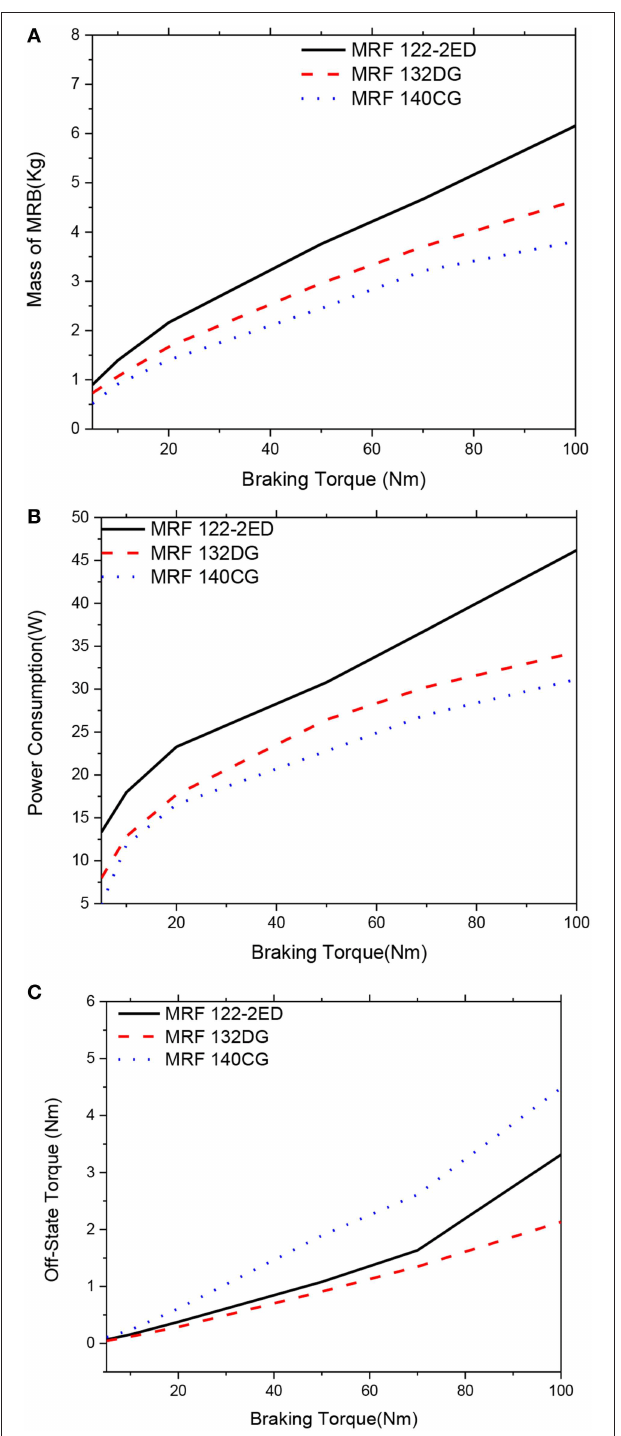
FIGURE 19 | Multi-objective optimization results of the MRBs as a function of braking torque of side-coil MRB, α m = 0.75; α P = 0.0; α To = 0.25. (A) Mass as a function of braking torque, (B) Off-state torque as a function of braking torque, (C) Power consumption as a function of braking torque.